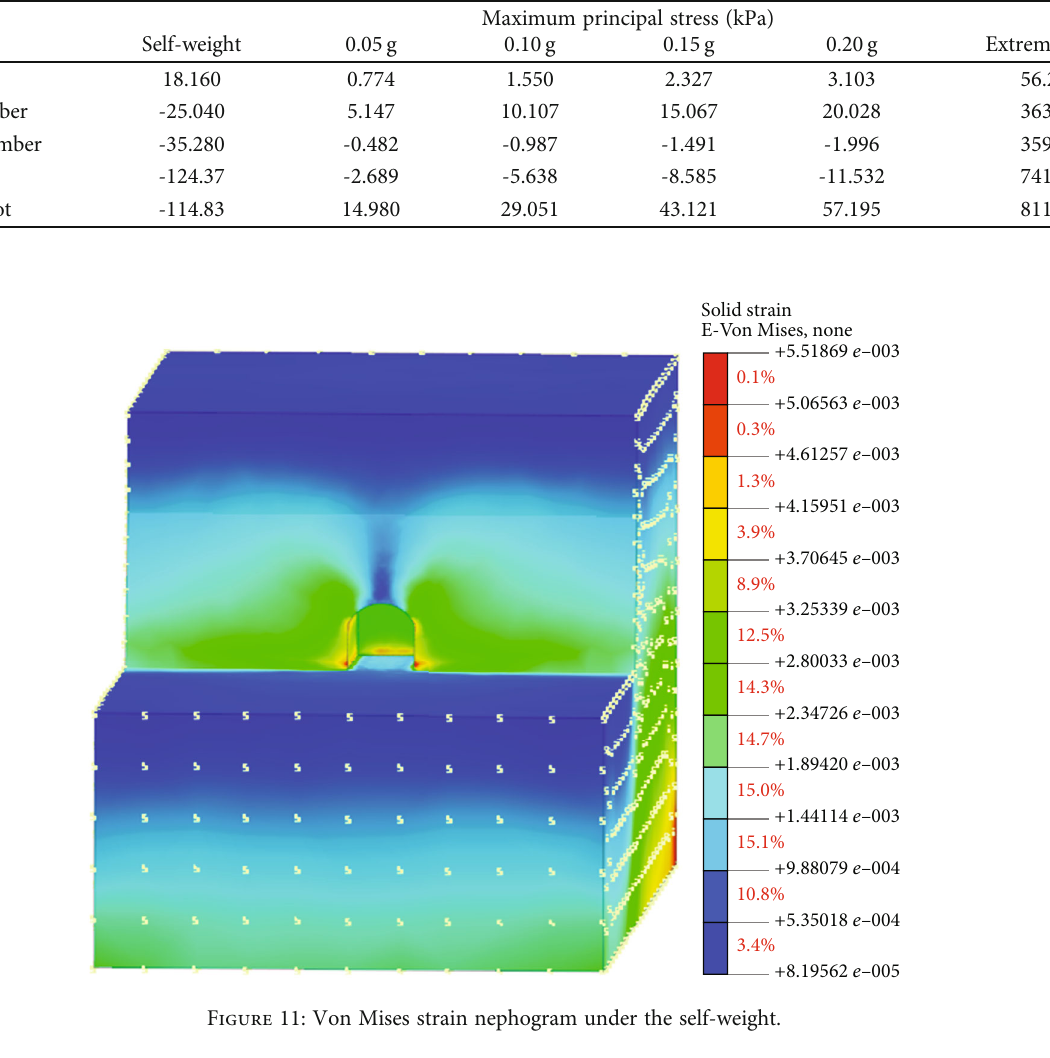
Table 5: Maximum principal stress values under self-weight and earthquakes at t = 2 : 2 s.